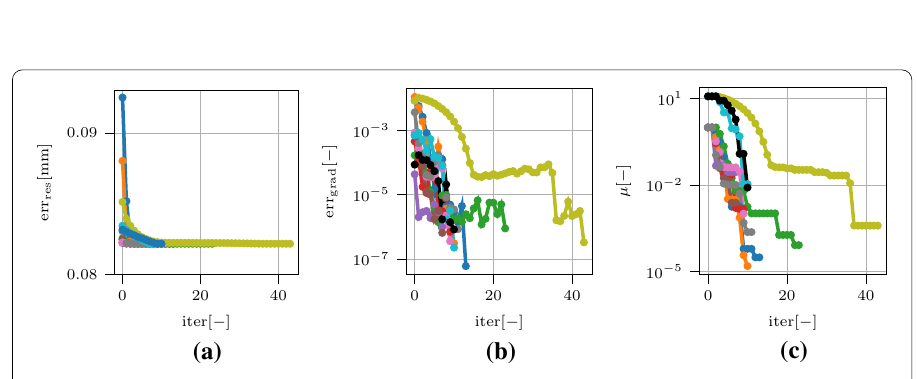
Fig. 8 Development of a residual error err res , b gradient based error err grad and c regularization parameter μ for inverse analysis runs with different initial guesses over iterations, with Gaussian noise with standard deviation σ = 10 − 2 mm added to the